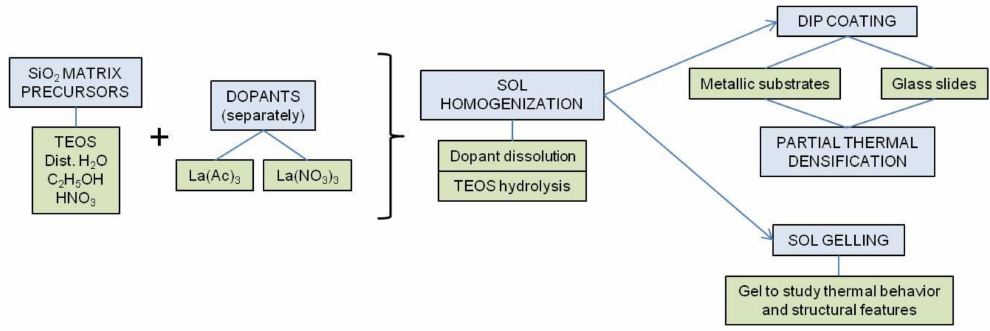
Figure 1. Scheme of the synthesis steps for obtaining sol-gel coatings and bulk